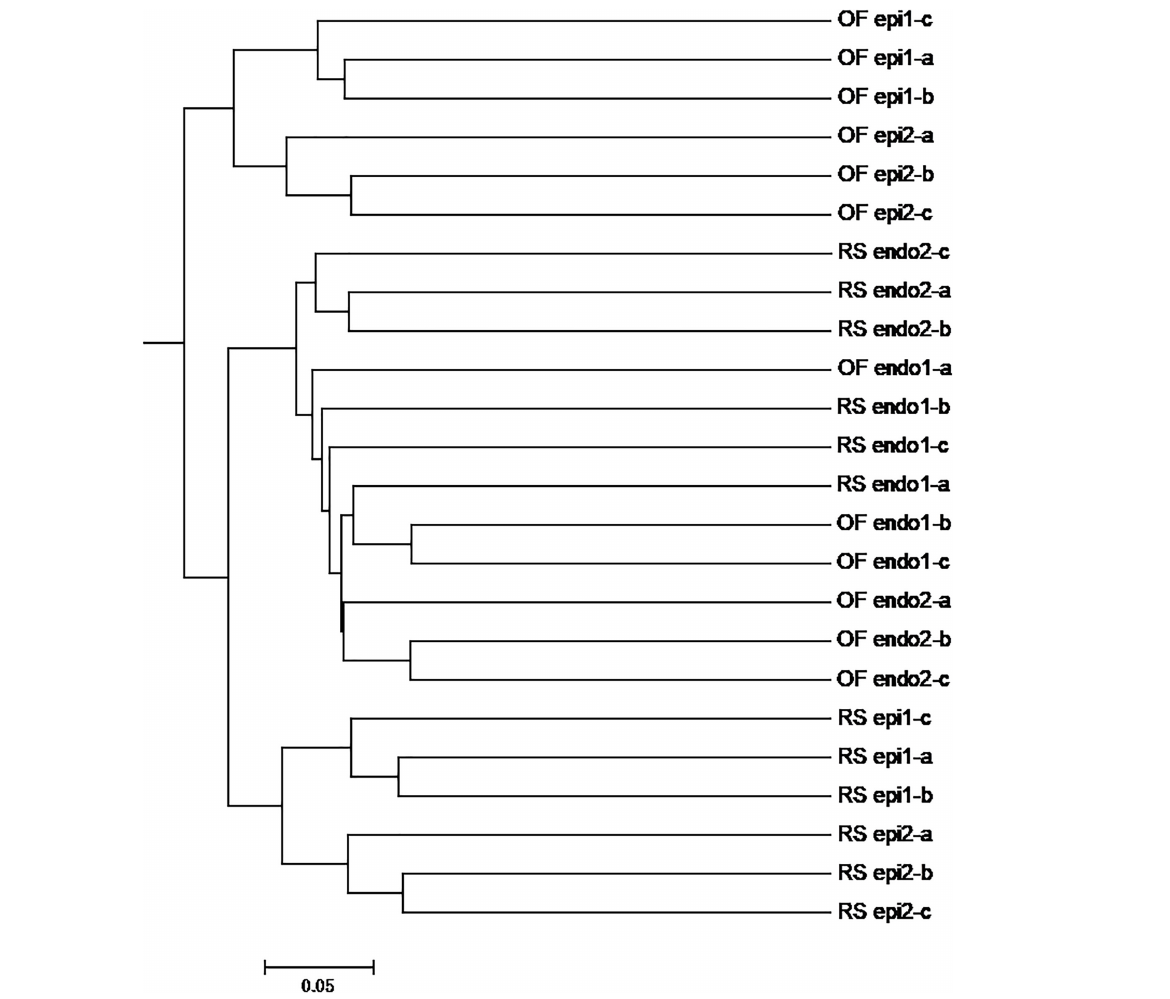
FIGURE 4 | UPGMA analysis of OTUs of bacteria community in different kiwifruit samples based on unweighted_unifrac distance. Note: In the samples, the prefix "RS" and "OF" mean rain-shelter cultivation and open-field cultivation, respectively; "epi" and "endo" represent epiphytic and endophytic, respectively; "1" and "2" indicate “Hongyang” and “Cuiyu” cultivars,